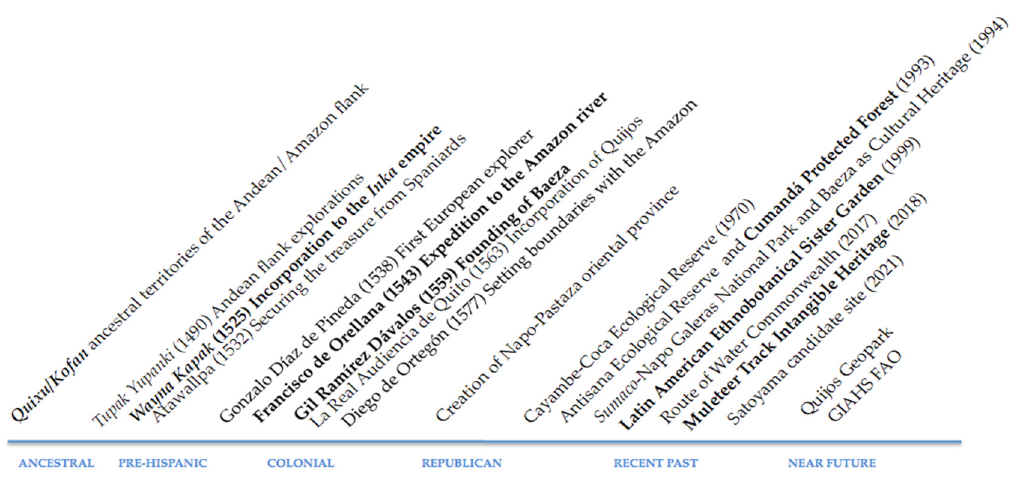
Figure 4. Timeline of the discovery and conservation efforts in the Quijos River valley in the Andean flank of the Ecuadorian Amazon, from prehistoric accounts to the historicity of the present, into the near future. Source: own design, 6 July 2021.